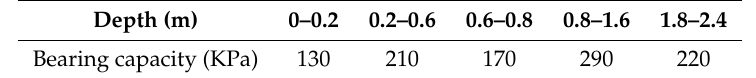
Table 2. Soil bearing capacity up to a depth of 2.5 m according to a CPT test.